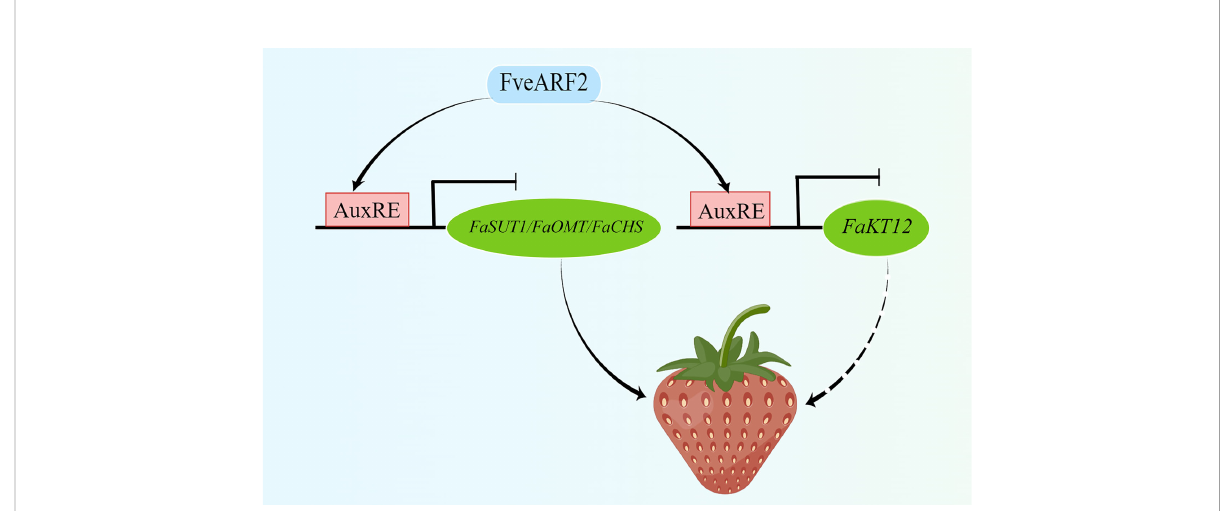
FIGURE 11 A model of FveARF2 as a negative regulator offruit ripening and quality in strawberry. FveARF2 directly binds to the promoters of FaCHS , FaSUT1 , and FaOMT and inhibits their expression; meanwhile, FveARF2 can also directly bind to the promoter of FveKT12 and inhibit its